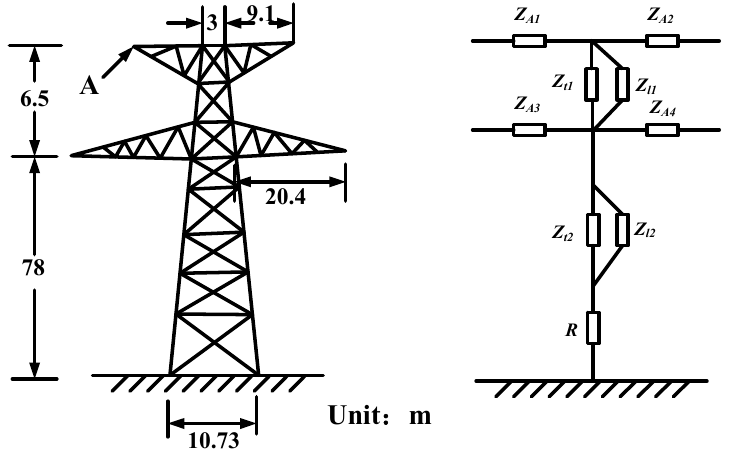
Figure 6. Parameters and the multi-surge impedance model of the tower. Table 1. Parameters of the tower.